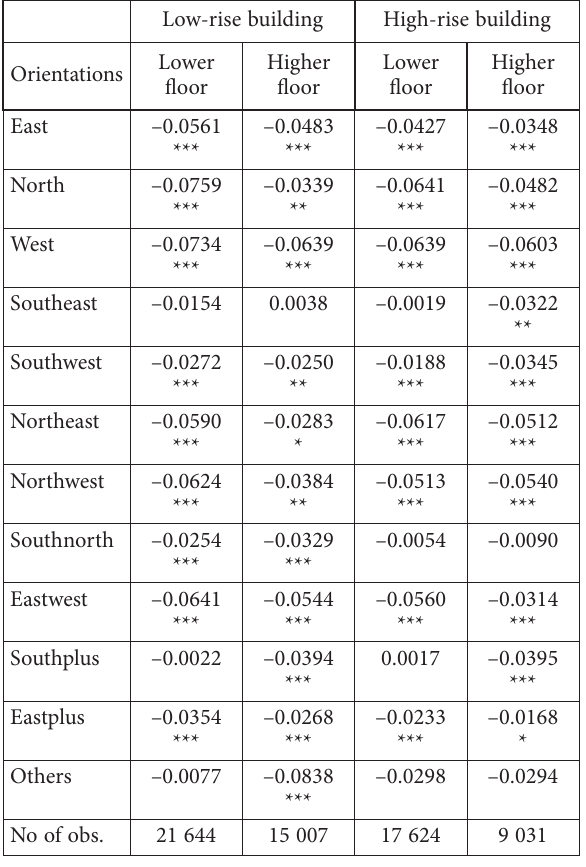
Table 6. The impact of type of building, floor and position on orientation